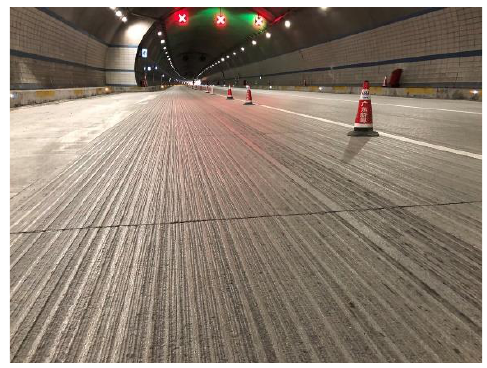
Figure 16. Textured pavement.